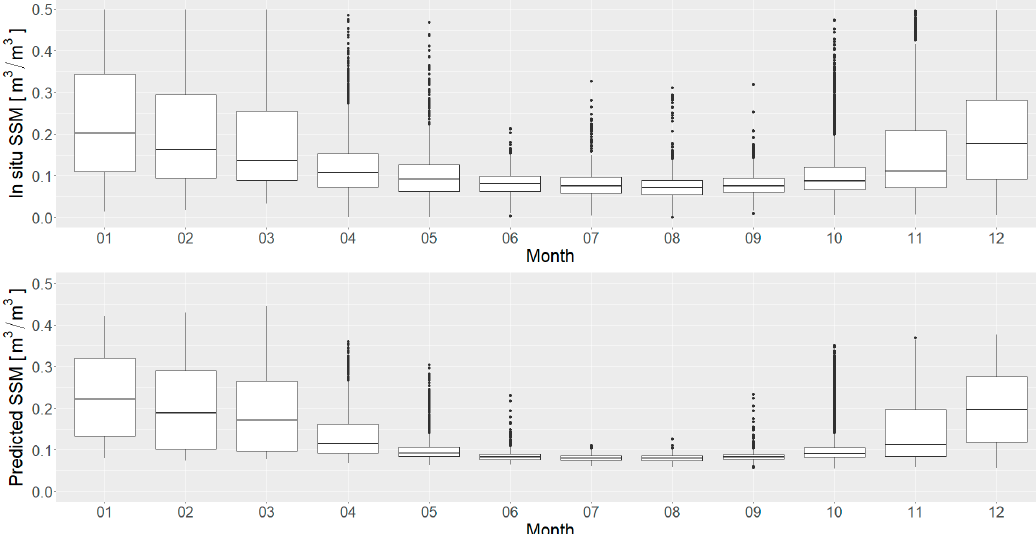
Figure 13. The boxplot charts of the in situ soil moisture observations and the five-fold cross-validations results (without NDVI shift), for every month of 2016.